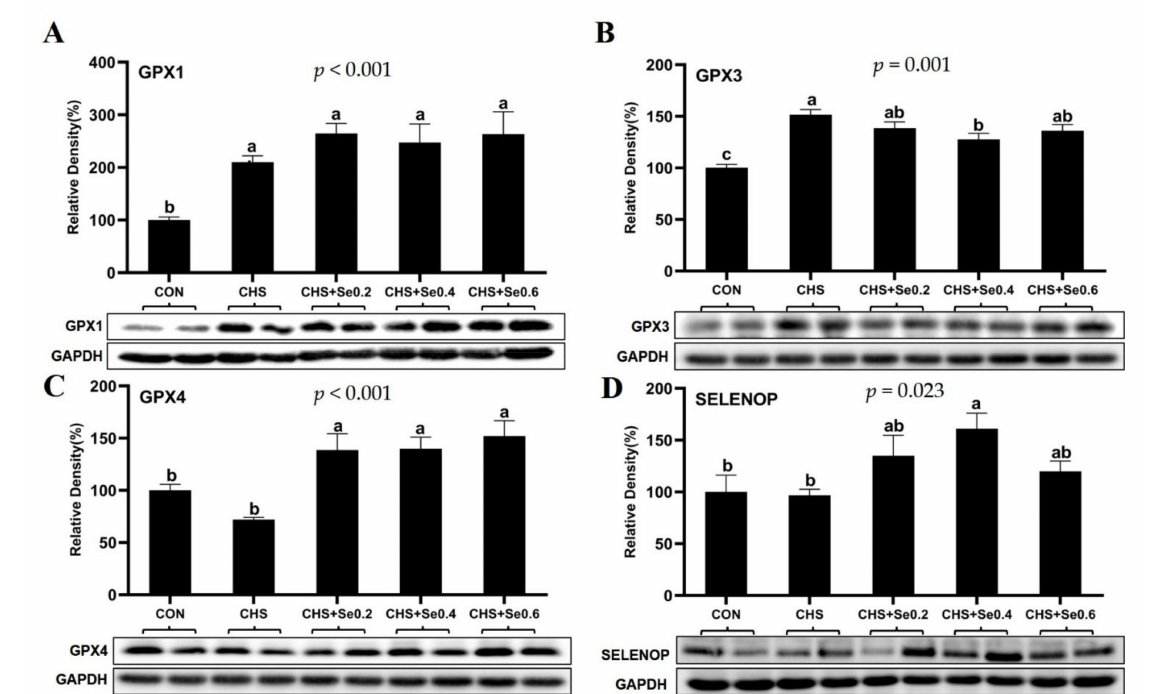
Figure 7. Effects of CHS and OH-SeMet supplementation on protein abundance of GPX1 ( A ), GPX3 ( B ), GPX4 ( C ), and SELENOP ( D ) in longissimus dorsi muscle. The results are expressed as Mean ± SEM ( n = 6). Different letters (a, b, c, d) denote significant differences ( p <